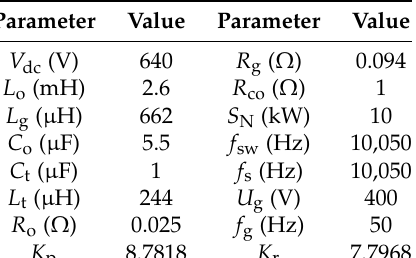
Table 4. Parameters of the 10-kW converter and the selected controller gains.